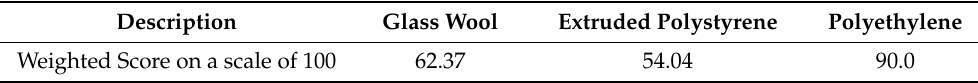
Table 7. Comparative analysis of scorecards of three test